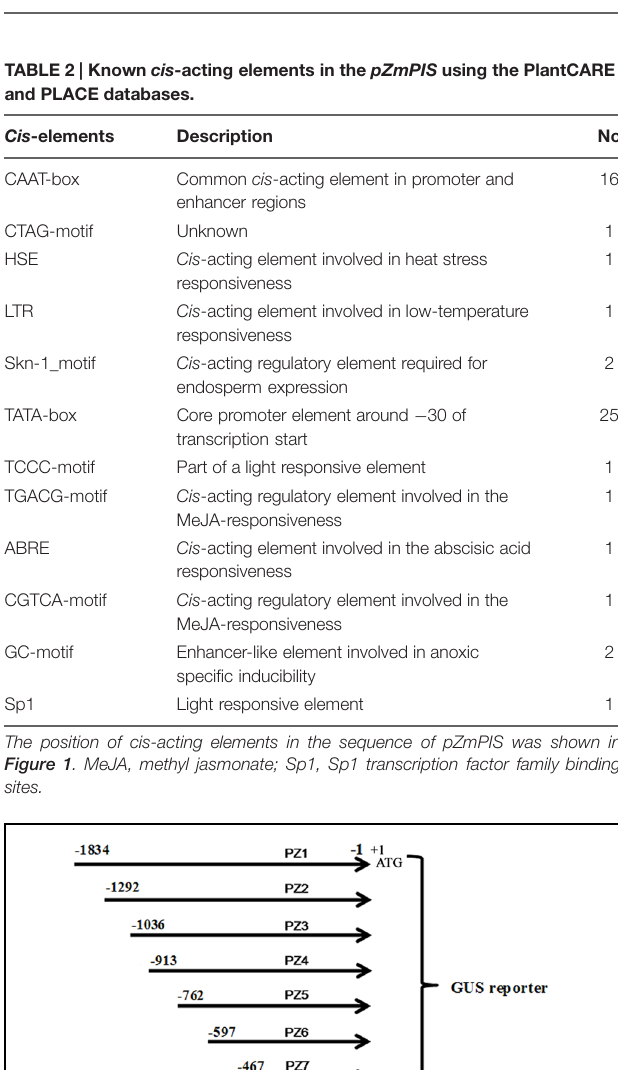
FIGURE 2 | The constructs of the truncated fragments of pZmPIS fused with GUS . A series of 5 (cid:2) deleted fragments of pZmPIS were placed upstream of the GUS reporter gene. The numbers indicate the nucleotide position from the translational initiate site, ATG (A as + 1).